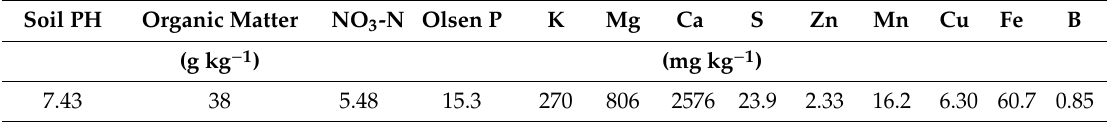
Table 2. Chemical properties of the soil used in Experiments 2 and